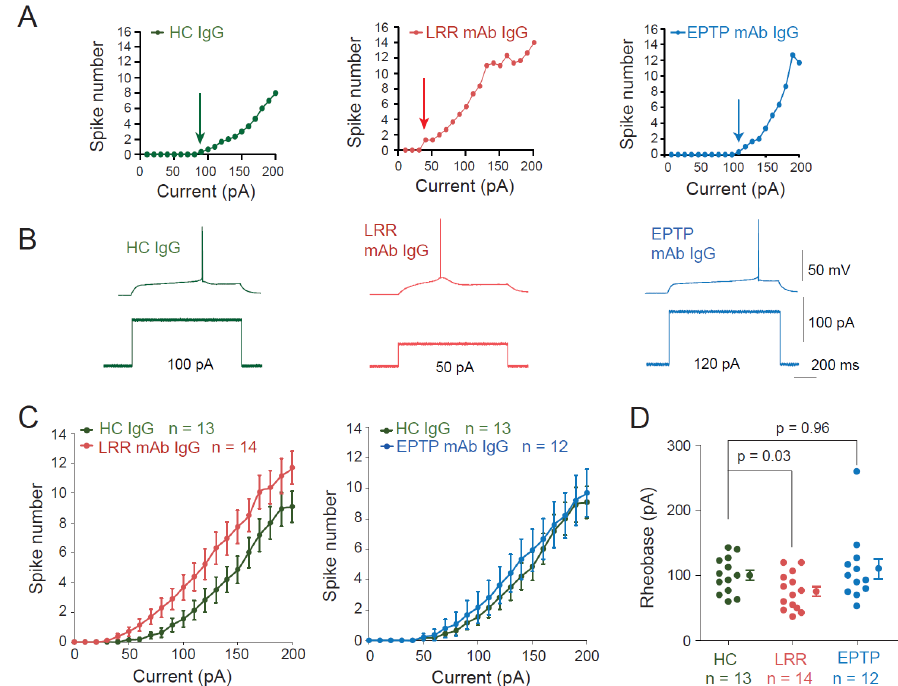
Figure 2. Application of patient-derived LRR-mAb increases intrinsic excitability of CA3 neurons. ( A ) Input–output curves of representative neurons from neurons in rat hippocampal organotypic cultures treated with HC-IgGs (green, left), LRR-mAbs (red, middle), and EPTP-mAbs (blue, right). Arrows indicate the rheobase current. ( B ) Corresponding traces illustrating the rheobase current. ( C ) Averaged input–output curves of LRR- and EPTP-mAbs were compared to control HC-IgGs. Note the leftward shift for LRR- but not for EPTP-mAbs. ( D ) Group data of the rheobase are current for each condition. Error bars represent SEM.